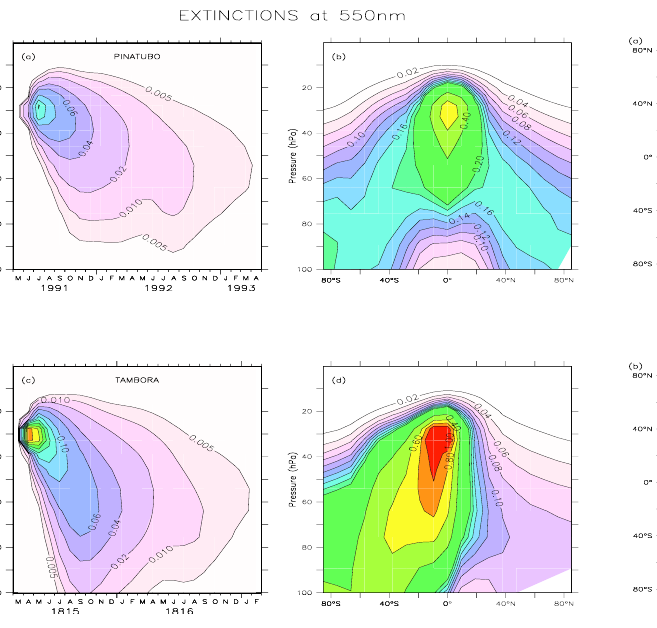
Fig. 3. Altitude distribution of the extinctions (1km − 1 ) in visible (550nm) for the Pinatubo and Tambora eruptions for this study. Left panel shows equatorial (5 ◦ S–5 ◦ N) mean values, right panels show 2yr cumulative monthly extinctions.